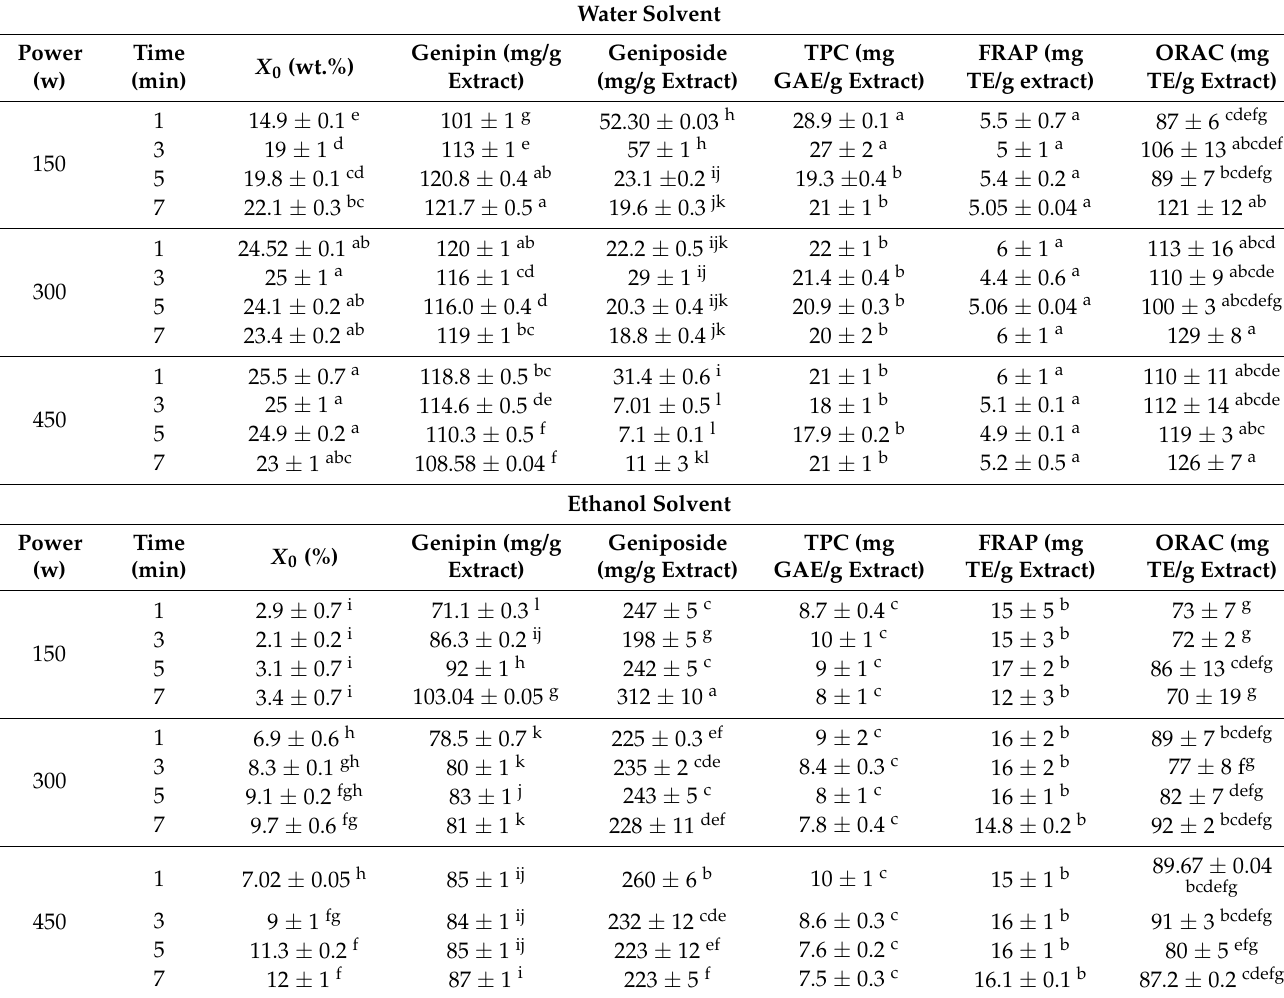
Table 1. Effect of the process parameters on extraction results. Water